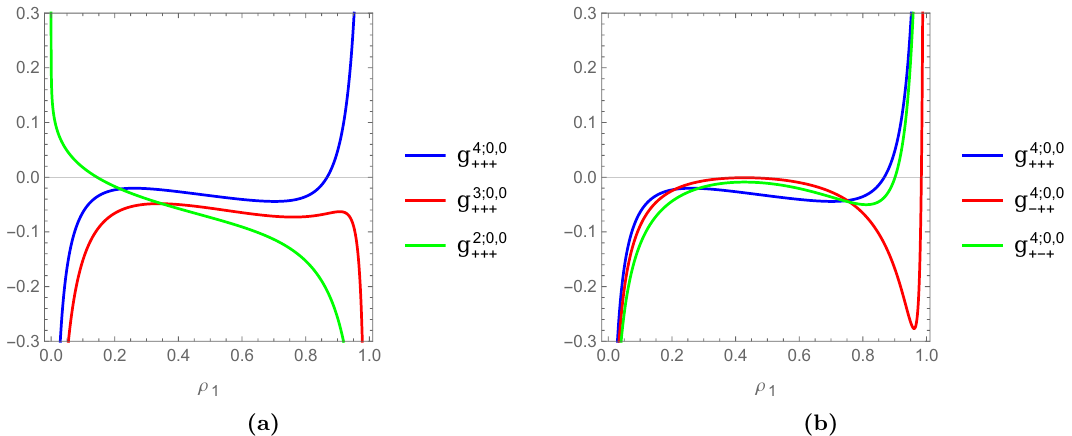
Figure 2 . Plots on the TPP symmetric line of the maximally subleading component in the LL expansion of the amplitude, i.e. the n 1 = n 2 = 0 component without any logs of the small variables τ 1 , τ 2 . (a) The 2-, 3- and 4-loop component of the MHV amplitude. (b) A comparison between the 4-loop maximally subleading components of the MHV, ( − ++) NMHV and (+ − +) NMHV component respectively. To facilitate numerical comparisons, the L -loop components are divided by ( − 16) L